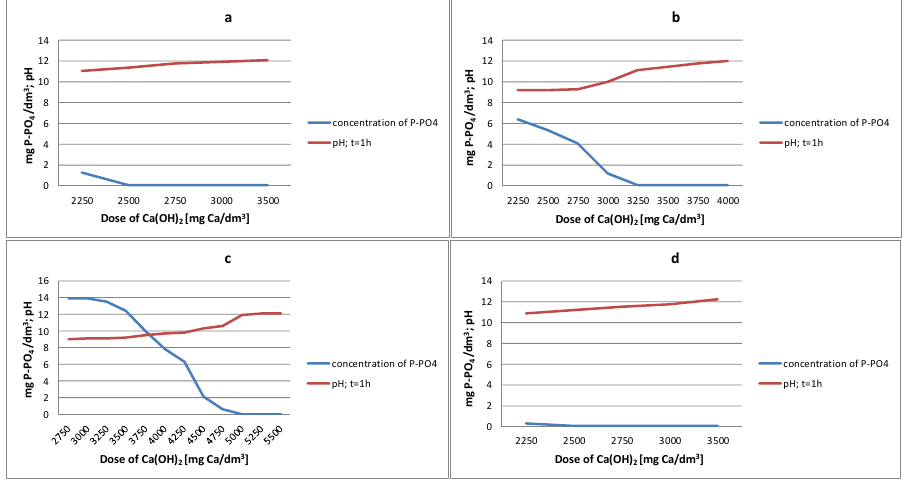
Figure 4. Changes in reject water P-PO 4 concentrations and pH changes for increasing doses of Ca(OH) 2 in the 4 analysed WWTP ( a ) Debogorze ( b ) Poznan ( c ) Slupsk ( d ) Swarzewo.